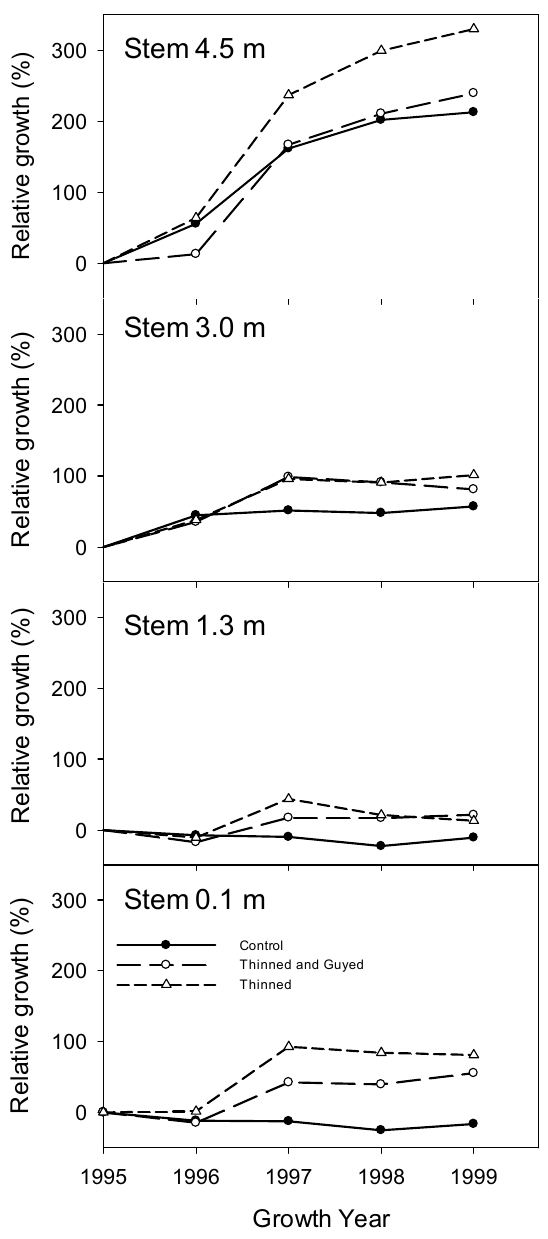
Figure 6. The relative (to size in 1995) diameter growth response following treatment, in stems at 0.1 m, 1.3 m, 3.0 m and 4.5 m above ground-level in growth years 1996, 1997, 1998 and 1999. Differences between treatments were significant at 0.1 m for 1997, 1998 and 1999 growth years (overall p = 0.004).